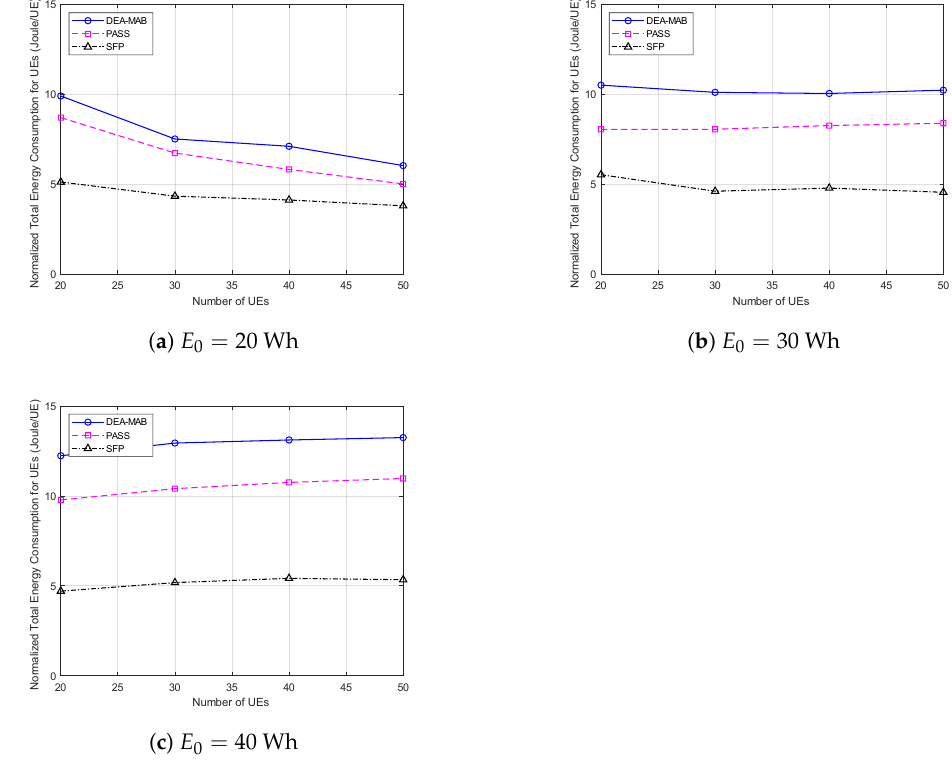
Figure 4. Normalized total energy consumption versus the number of